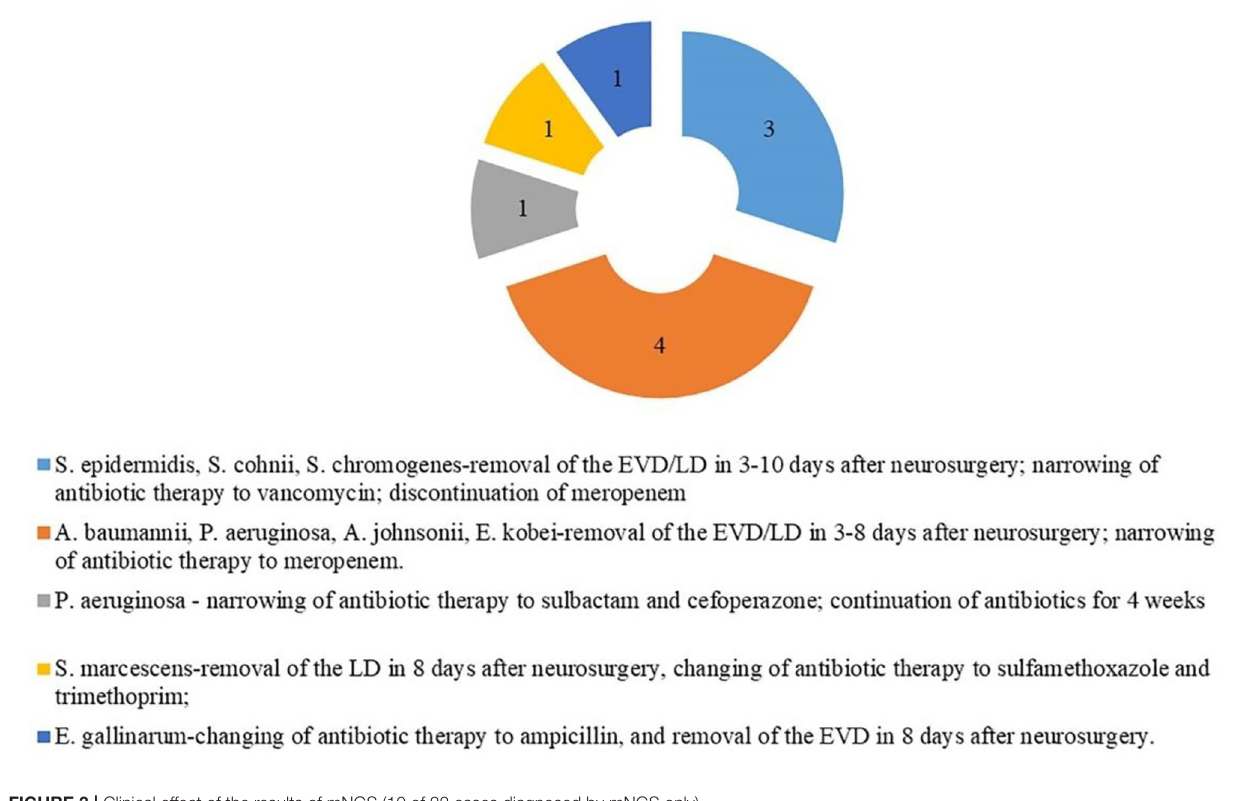
FIGURE 3 | Clinical effect of the results of mNGS (10 of 22 cases diagnosed by mNGS